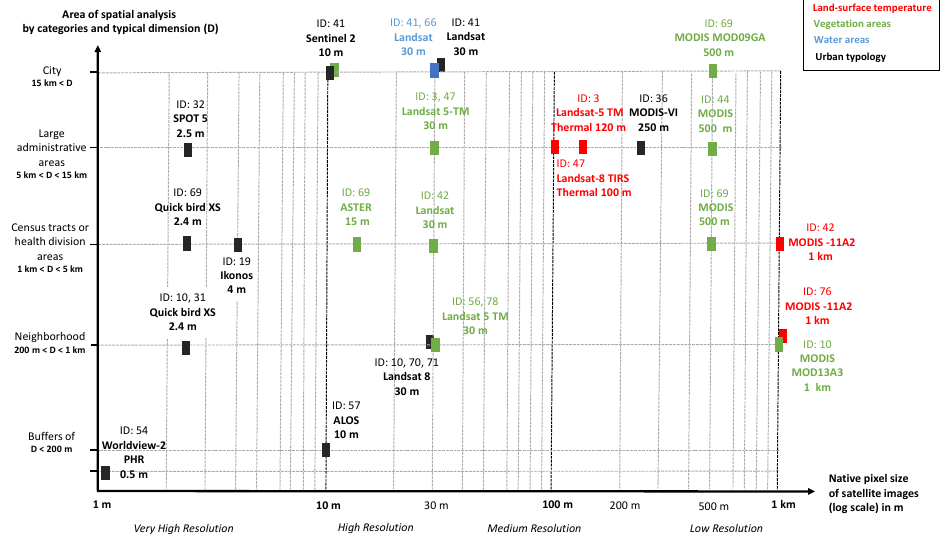
Figure 11. Comparison between pixel size (x axis, in log scale) and typical dimension of geographical area used to perform relationships with dengue cases (Y axis, in qualitative